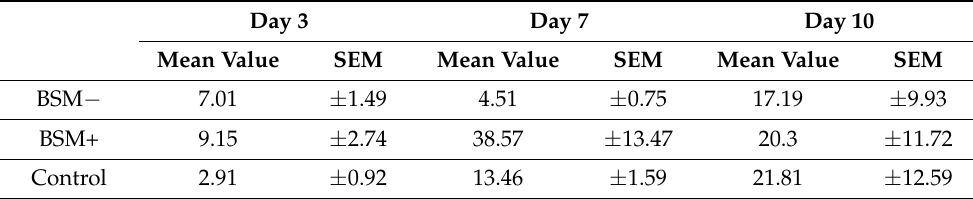
Table 2. Migration ability: Percentage area fraction of the scratch gap (%) of fluorescence-stained HOBs at a ten-fold magnification for BSM − (cerabone ® ), BSM+ (cerabone ® Plus including HA) and the control (HOB alone) on days 3, 7 and 10. The mean values are for parametric data and the median values are for non-parametric data.